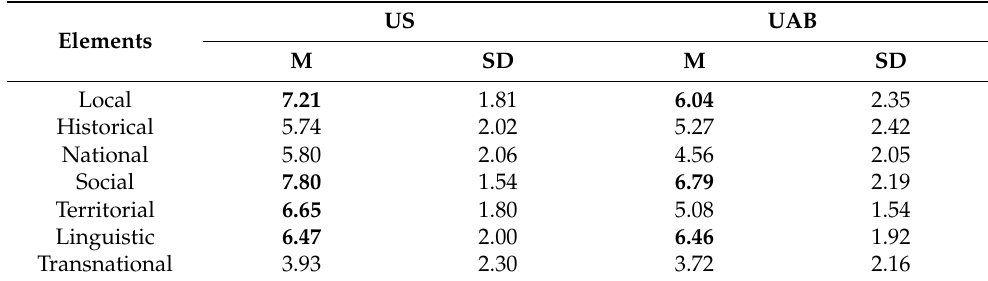
Table 3. Descriptive elements that configure identities.